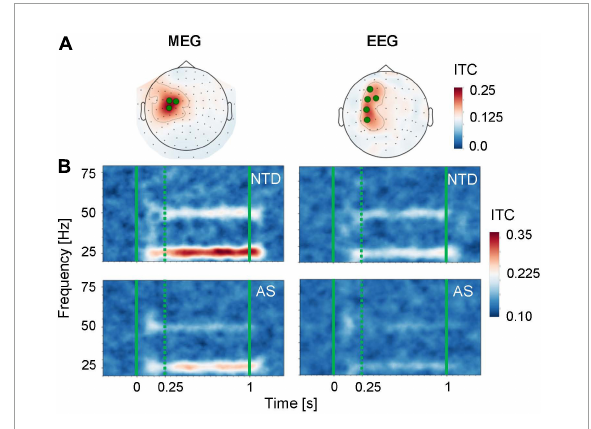
FIGURE3 Time-frequency representation of the ITC for the responses to the 25-Hz tactile stimulation. (A) Topographic maps of the ITC values were averaged over all subjects (NTD and AS combined) within the 25 and 50-Hz frequency bins and the 250–1,000 ms time window. The green dots indicate frontocentral MEG ( left ) and EEG ( right ) sensors that were selected for all subsequent analyses. (B) Time-frequency maps of the ITC for the NTD ( top ) and AS ( bottom ) groups, averaged over the selected sensors. The solid green vertical lines indicate the onset and offset times of the stimulus, and the green dotted line indicates the beginning of the time window used for the analysis of the steady state component of the response.